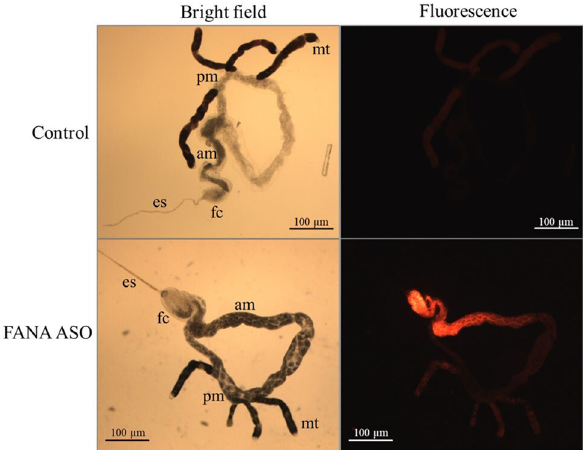
Figure 4. Localization of FANA oligo in the alimentary canal of D. citri adults. Psyllid guts were dissected and imaged after feeding on Citrus leaves previously treated with a 5 µM solution of an Alexa Fluor 594 labeled